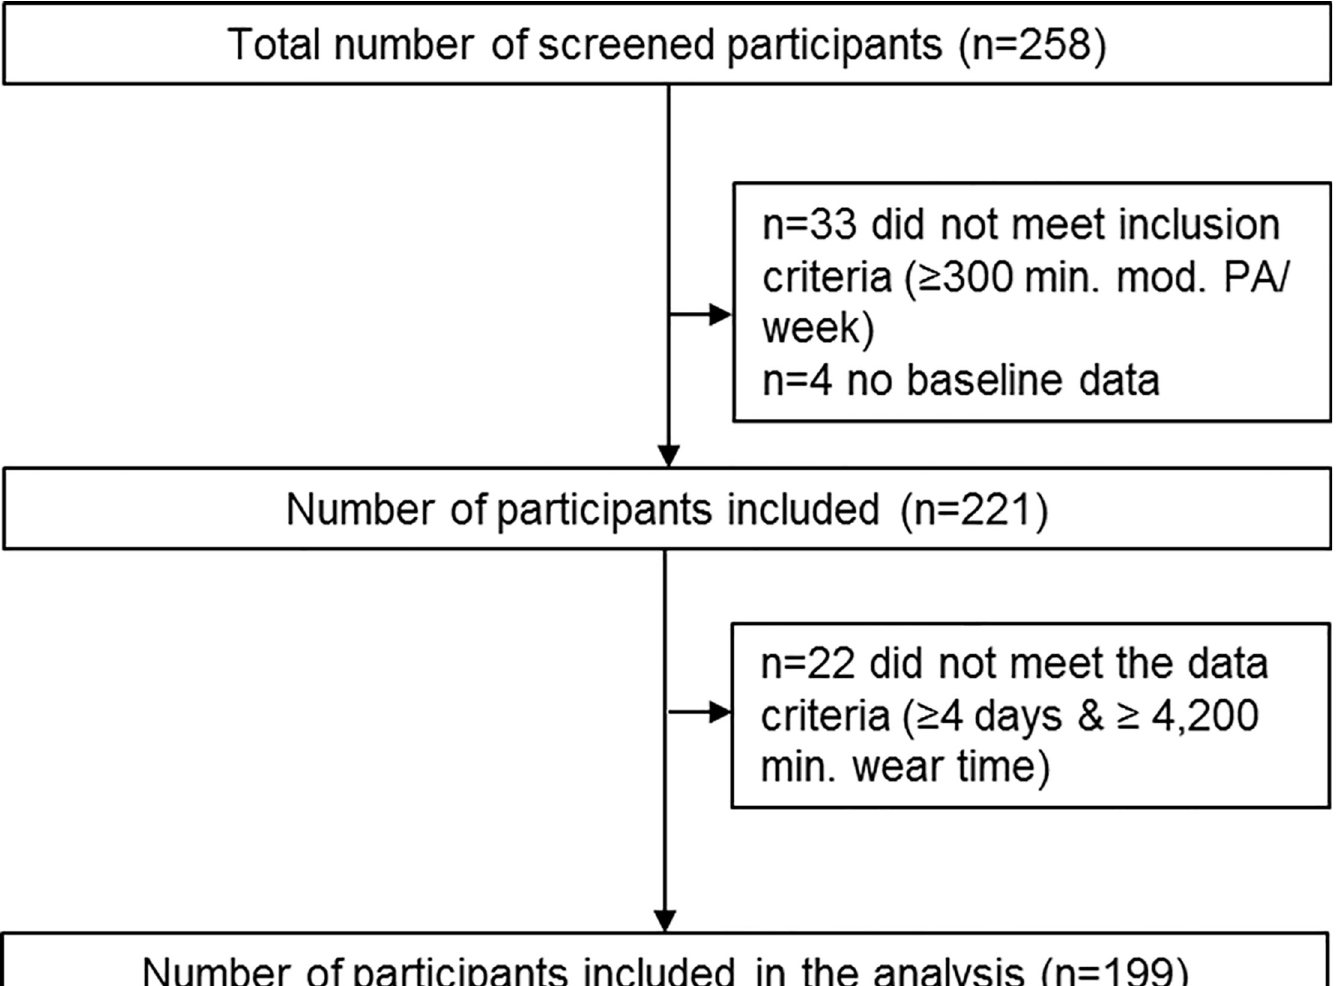
Fig 1. Number of recruited participants and participants included in the analysis.